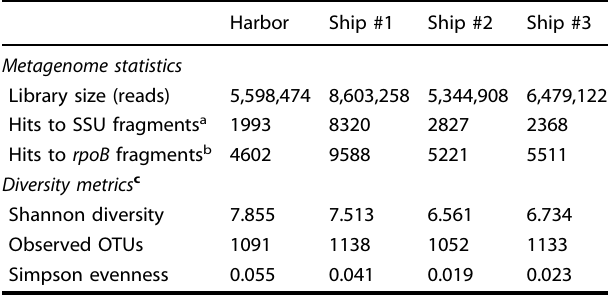
Table 3. Summary of metagenome library statistics and extracted community diversity